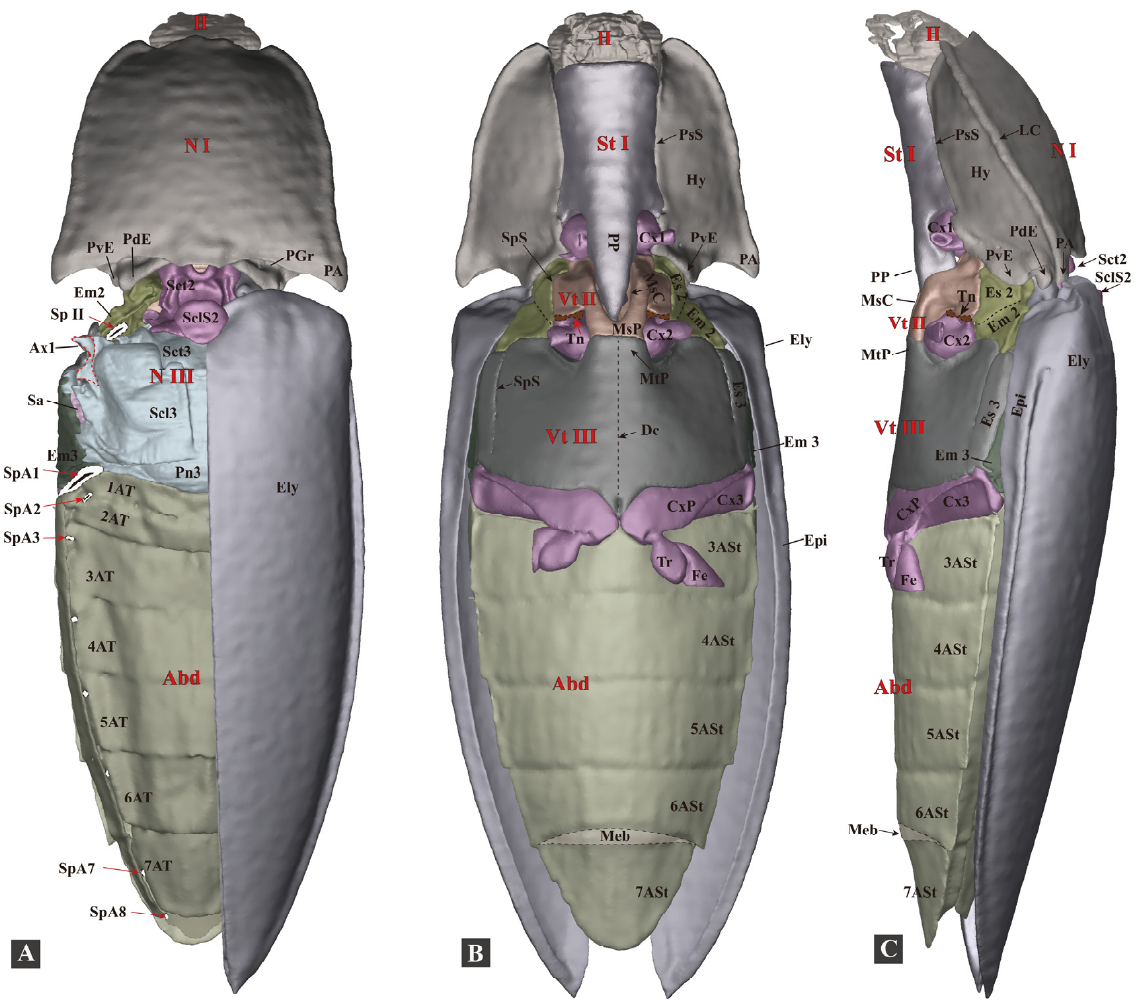
Figure 3. Three-dimensional reconstructions of the exoskeleton of Campsosternus auratus . The specimen is in a resting position; for technical information and abbreviations, see Section 2 ‘Materials and Methods’. ( A ) Dorsal view of habitus; left elytron is removed to show the structures beneath; and the Ax1 of the mesothorax and the spiracles were edited in Photoshop, shown in dotted lines. ( B ) Ventral view of habitus. ( C ) Lateral view of